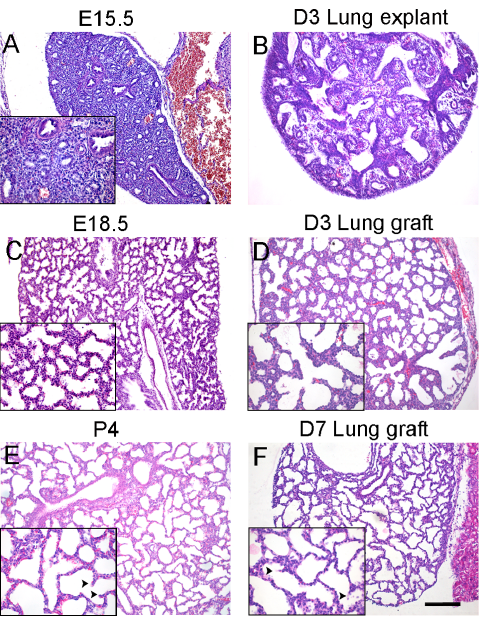
Figure 2. Morphogenesis of murine fetal distal lung allografts underneath the renal capsule. E15.5 WT lungs were diced and implanted underneath the renal capsule. Sections of fetal lung tissues, explants and allografts at indicated time points were stained with Hematoxylin and eosin (H&E) and shown at low and high (inserts) magnification. (A) E15.5 lung tissue, (C) E18.5 lung tissue, (E) P4 lung tissue, (B) day 3 explant, (D) day 3 allograft, (F) day 7 allograft. Arrowheads indicate secondary septae (E–F). Scale bar, 100 m